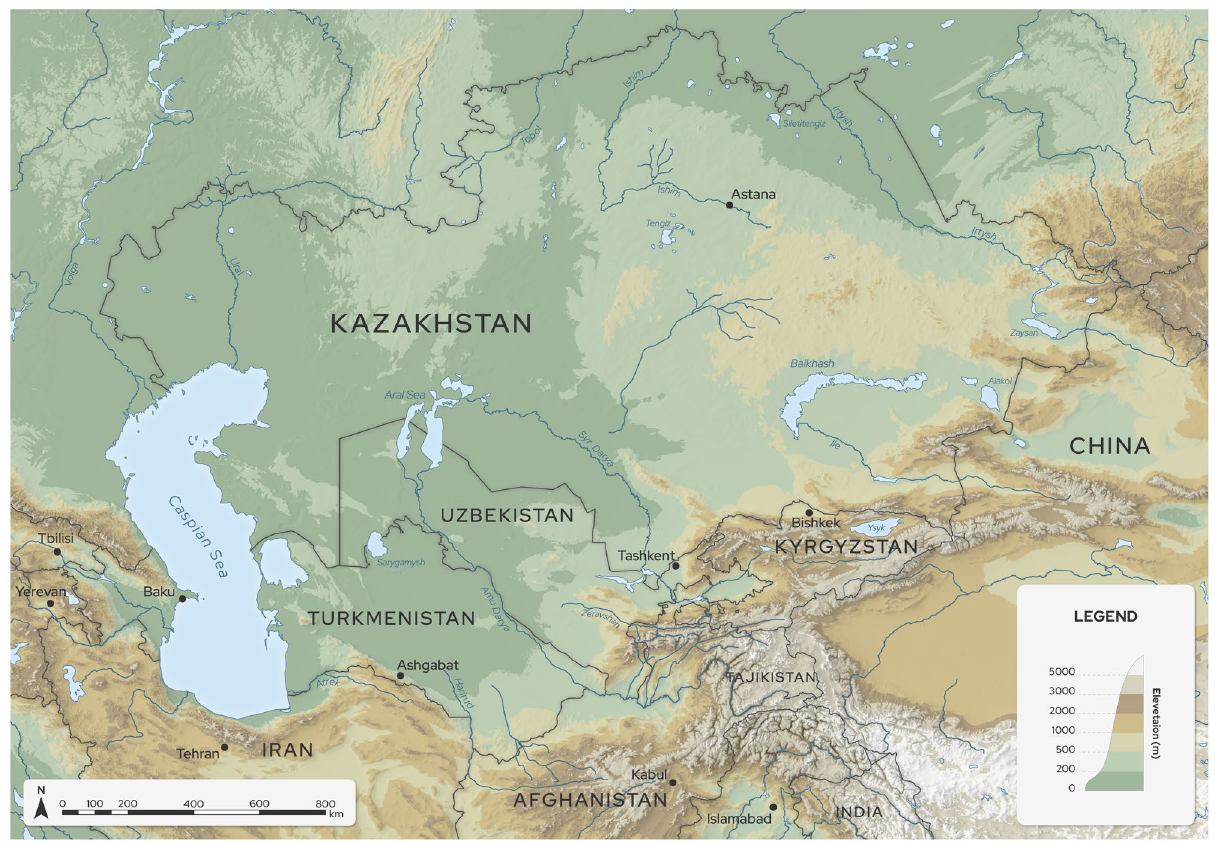
Figure 1. Central Asian domain and topography(m). The boundary data were taken from Natural Earth. Free vector and raster map data at www. natur alear thdata. com. The basin and river data were taken from HydroATLAS 34 . The elevation data were downloaded from the ASTER Global Digital Elevation Map 35 . The map was created using ArcGIS V10.8.2 (https:// www. esri. com), Adobe Illustrator Version 27.2 (www. adobe. com) and Blender V3.4.1 (www. blend er.